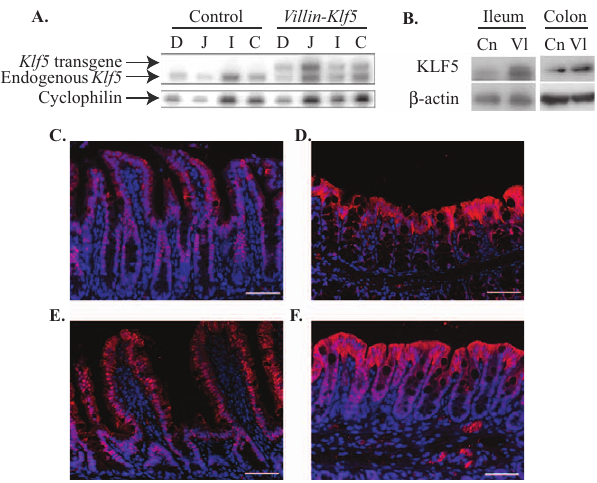
Figure 1. Villin-Klf5 transgene was expressed in small and large intestinal epithelia. ( A ) RNAse protection assay demonstrated strong transgene expression in the duodenum (D), jejunum (J), ileum (I), and colon (C) of Villin-Klf5 mice, compared to their littermate controls. Cyclophilin was used as a loading control. ( B ) At 1 month of age, compared to controls (Cn), Villin-Klf5 mice (Vl) had increased KLF5 expression in the small intestine and colon by Western blot. ( C–D ) Immunofluorescence of 6 month-old control mice revealed nuclear KLF5 staining restricted to small intestinal crypts (C) , with weak nuclear staining in colonic crypt cells ( D ). ( E-D ) Villin-Klf5 mice at 6 months of age had stronger KLF5 staining, with nuclear staining seen along the entire crypt-villus axis of the small intestine ( E ) and increased numbers of KLF5-positive cells in colonic mucosa ( F ). In both control and Villin- Klf5 mice, cytoplasmic KLF5 staining was seen in the surface epithelia. Scale bars: 50 m m.